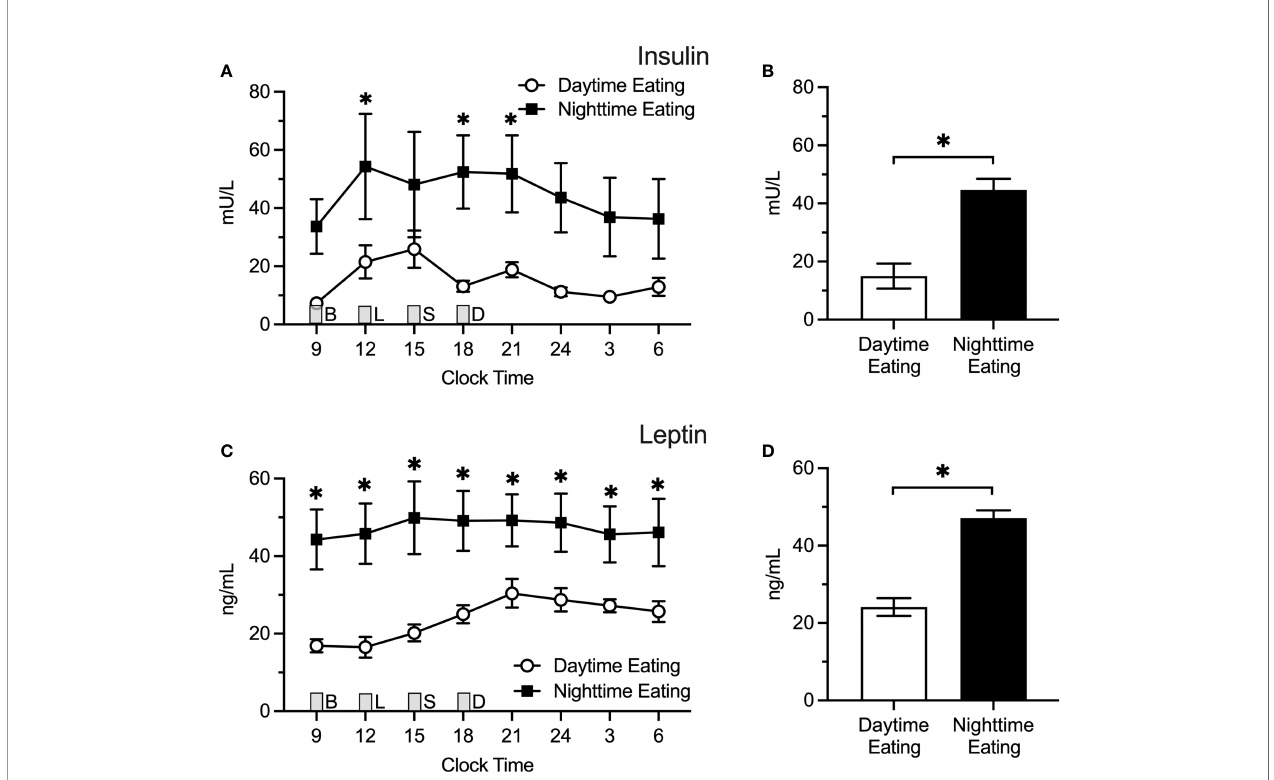
FIGURE 4 | Insulin and Leptin Levels in Predominant Daytime Eating ( n = 4) Versus Predominant Nighttime Eating ( n = 5) Nightshift Nurses. Nighttime eating in nightshift nurses was associated with higher insulin and leptin levels. (A, C) Raw values ± SEMs for insulin and leptin as a function of clock time and shift type. (B, D) Mean 24-h values ± SEM for insulin and leptin by shift type, as derived from generalized additive models. Meals were served at 09:00 (B, breakfast), 12:00 (L, lunch), 15:00 (S, snack), and 18:00 (D, dinner) and are designated with a grey box. *p <